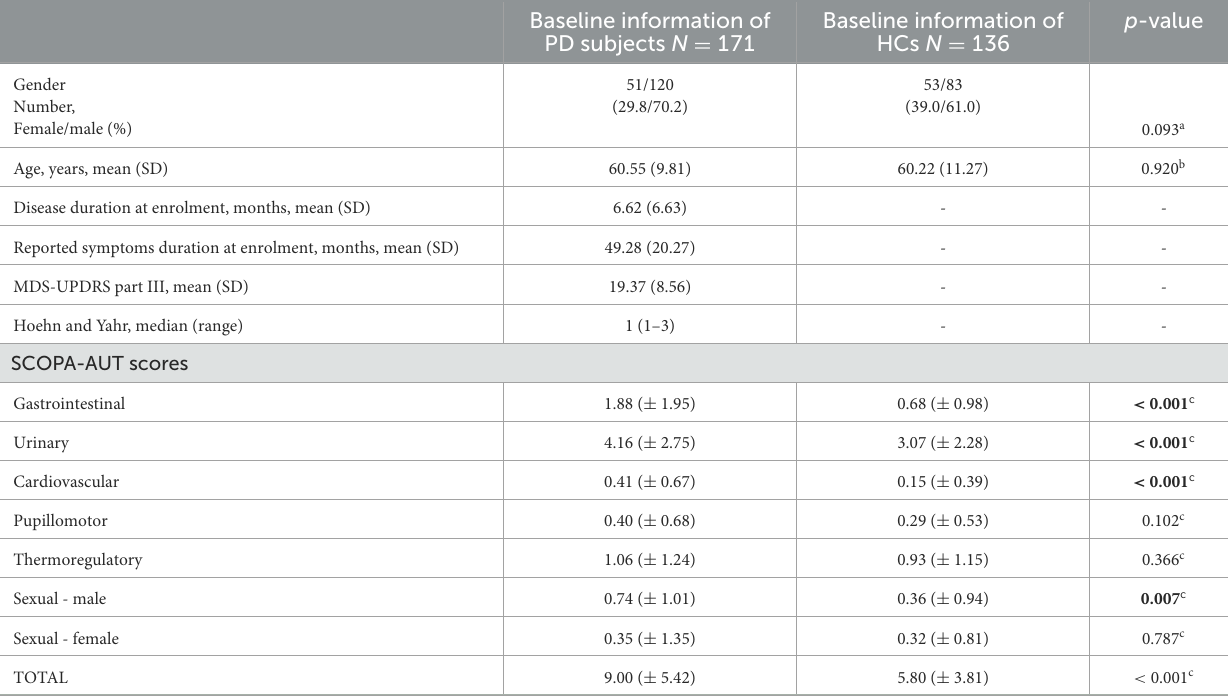
TABLE 1 Baseline clinical and demographic features of Parkinson’s Disease (PD) and healthy participants